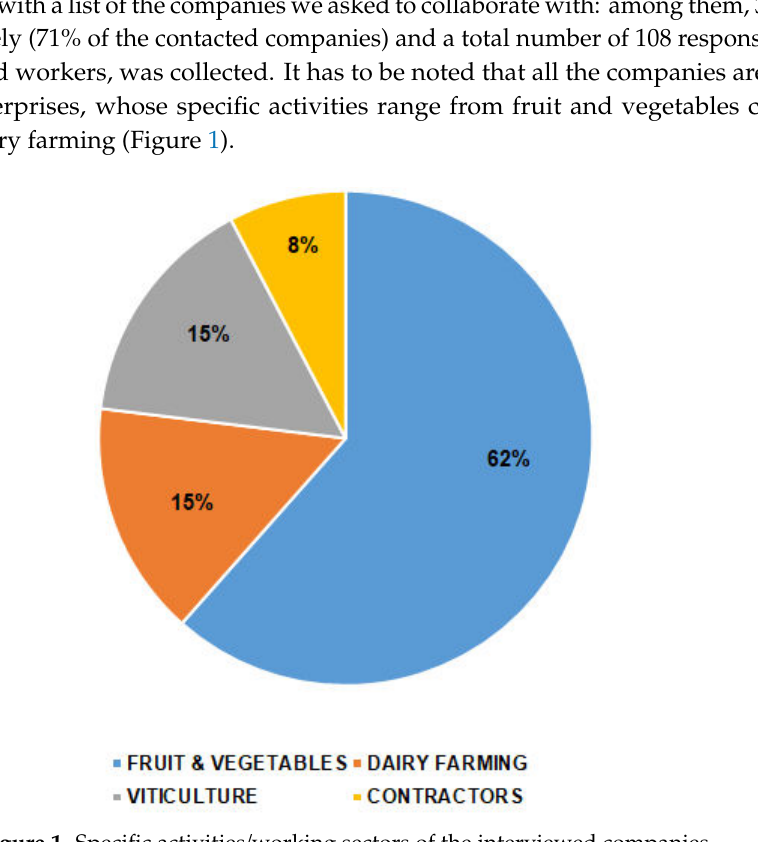
Figure 1. Specific activities / working sectors of the interviewed